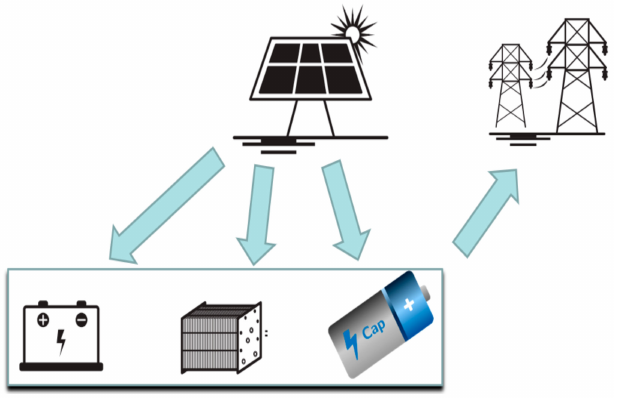
Figure 1. Hybrid storage